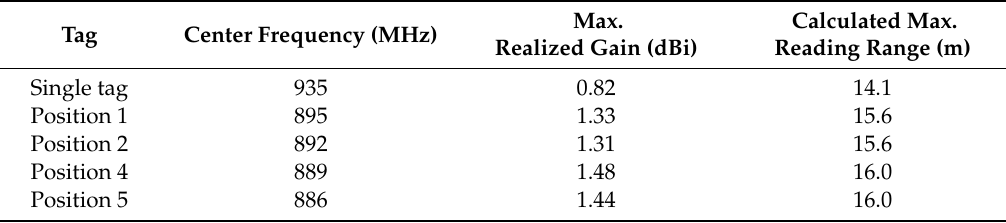
Table 3. Simulation results and calculated reading ranges of single tags and tags in an array (4 W equivalent isotropic radiated power (EIRP); US standard RFID band by the Federal Communications Commission (FCC